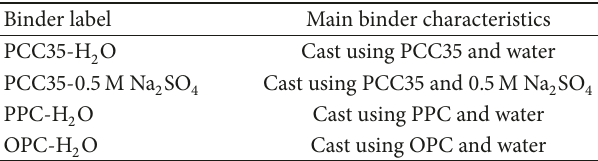
Table 1: Binder characteristics of the mortars. Binder